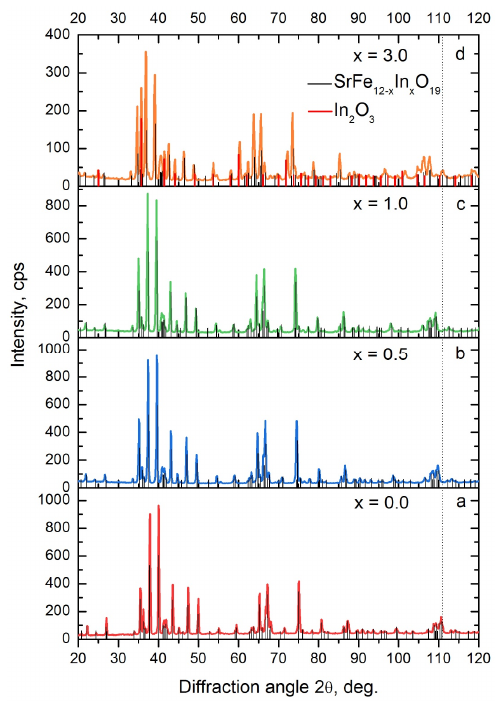
Figure 1. XRD patterns of samples SrFe 12 − x In x O 19 after mechanochemical synthesis and annealing at 1200 ◦ C, 1 h: x = 0 ( a ); x = 0.5 ( b ); x = 1.0 ( c ); x = 3.0 ( d